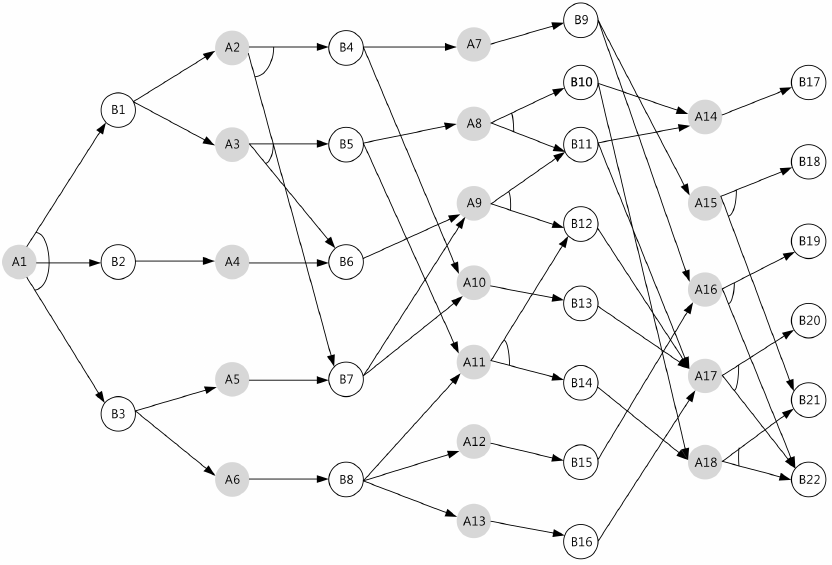
Figure 1. An illustrative example of a disassembly path for Phase I of the line planning